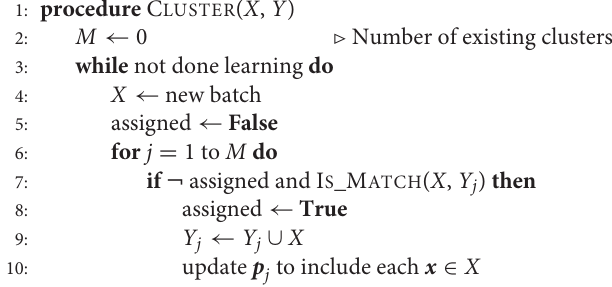
Active dendrites network (task info. provided)